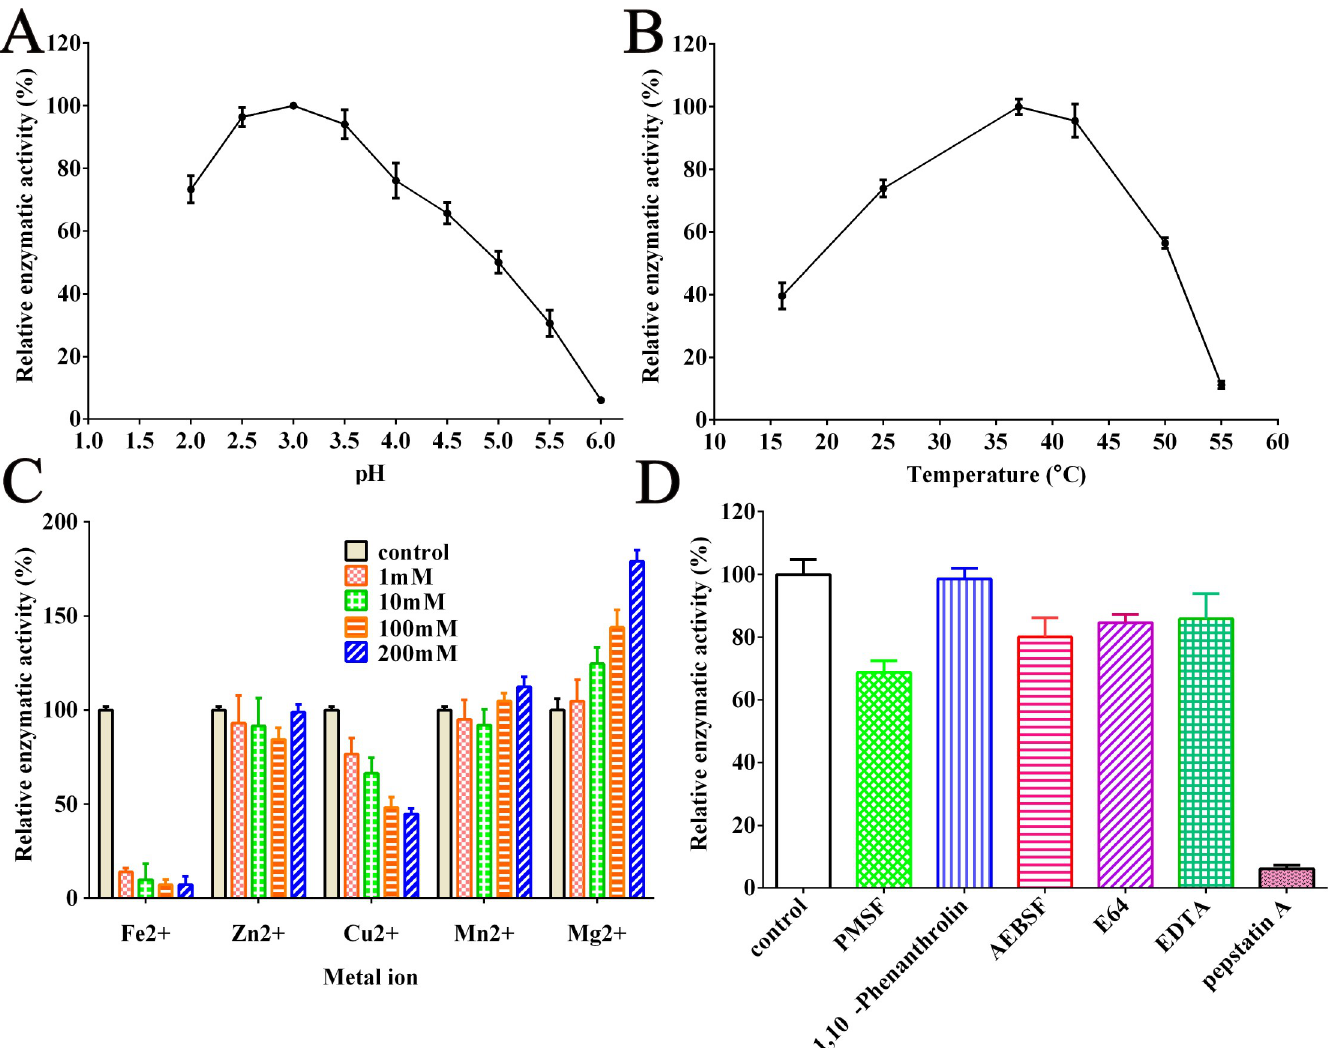
Fig 6. Enzymatic activity assay via cleavage of fluorescence substrate. A: The optimal pH of rTsASP2 enzymatic activity. B: The enzymatic activities were assayed at 15–55˚C: The effects of metal ions on enzymatic activities. The assays were carried out under different metal ion concentrations. D: The effects of various inhibitors on enzymatic activities, where the concentration of inhibitors was 1 mM of PMSF, 1 mM of 1,10-phenanthrolin, 1 mM of AEBSF, 10 μ M of E64, 1 mM of EDTA, and 10 μ M of pepstatin A. All the enzymatic activities were expressed as the relative activity of the highest reaction in each